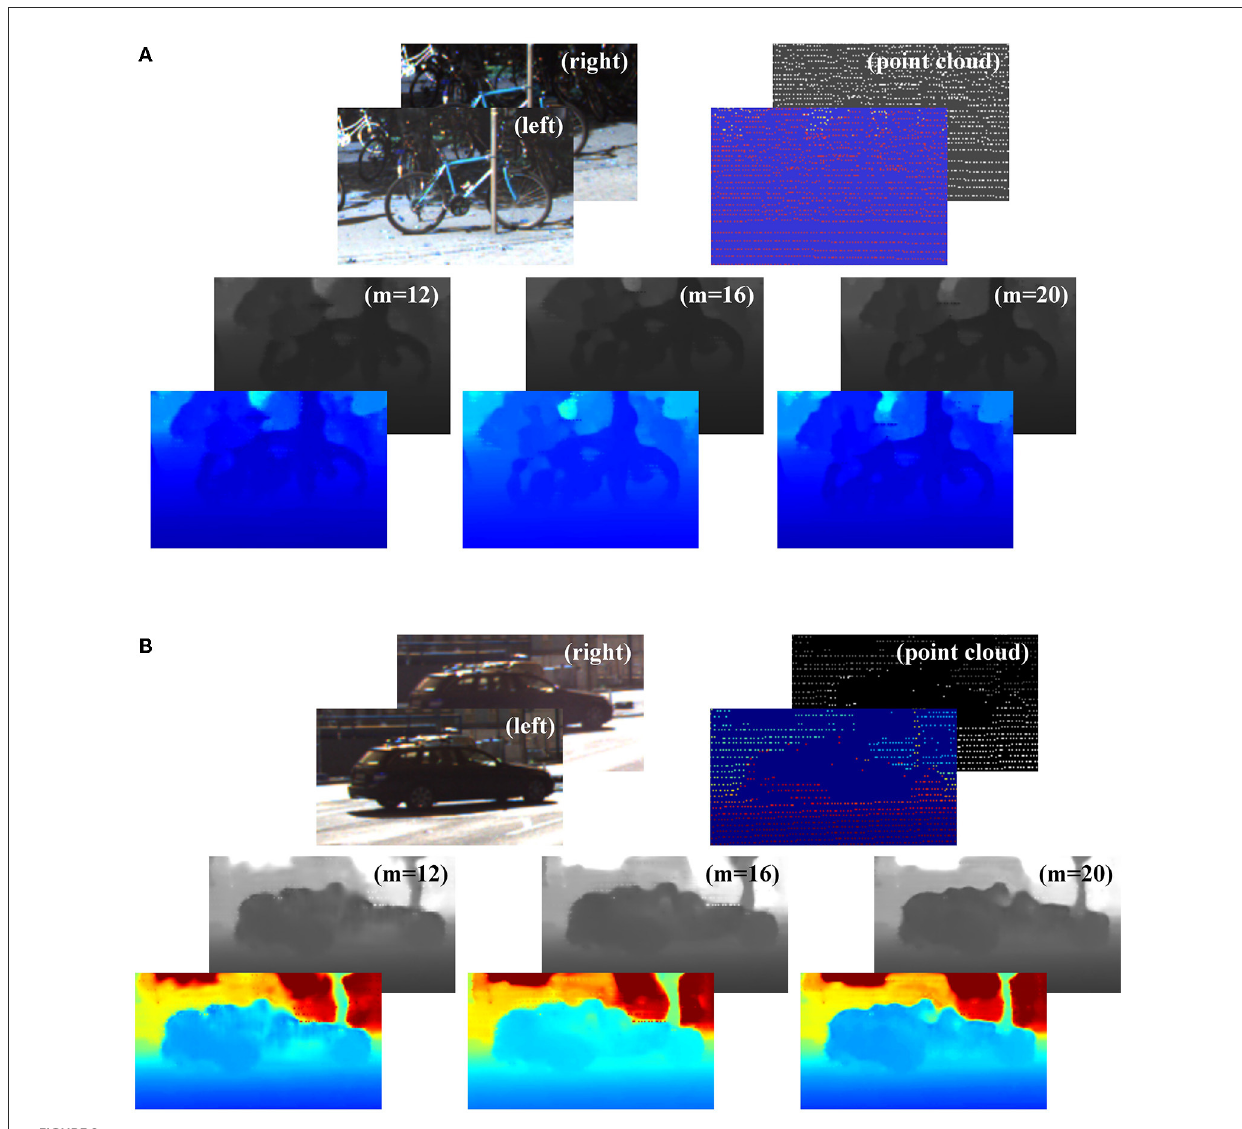
FIGURE9 The effects of the injected guided updating kernel-connected depth refinement module. (A) is a bicycle and (B) is a car, both of which are specific targets for 3D information acquired by sensors. The top left image pair is binocular images. The top right is the point cloud. The following three images are the fine-depth images obtained at iterations 12, 16, and 20, respectively. The overlapped image at the bottom left is their false-color